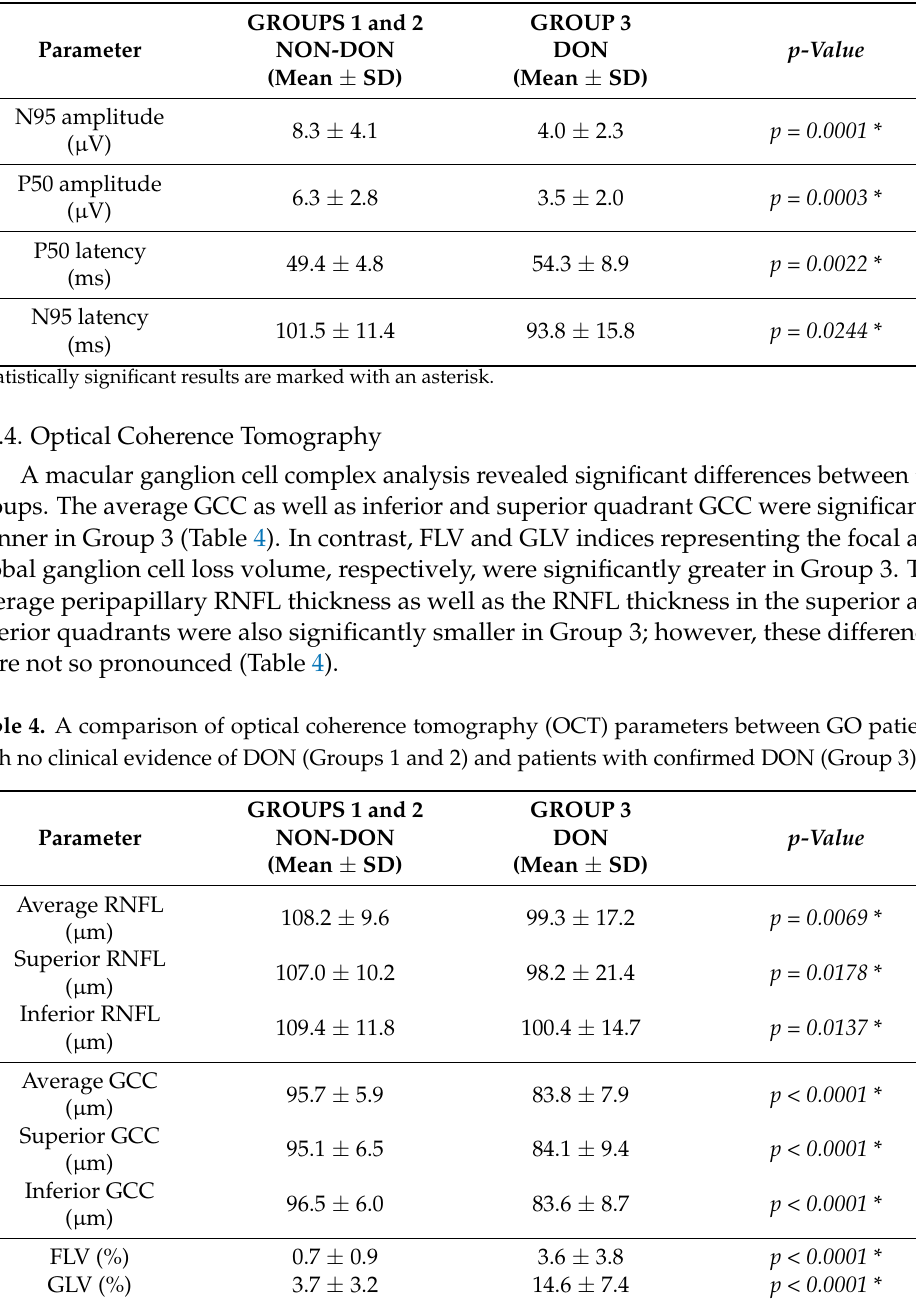
Table 3. A comparison of pattern electroretinogram (PERG) components between GO patients with no clinical evidence of DON (Groups 1 and 2) and patients with confirmed DON (Group 3).